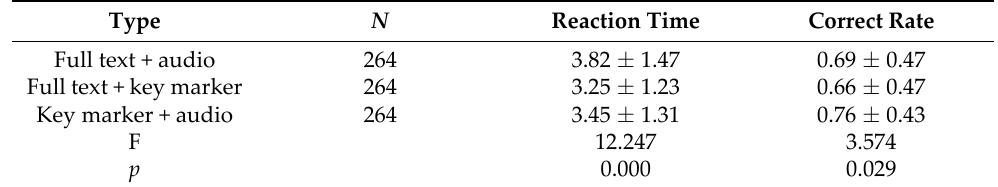
Table 4. DUNCAN post hoc multiple comparison results showing mode response time and correctness.